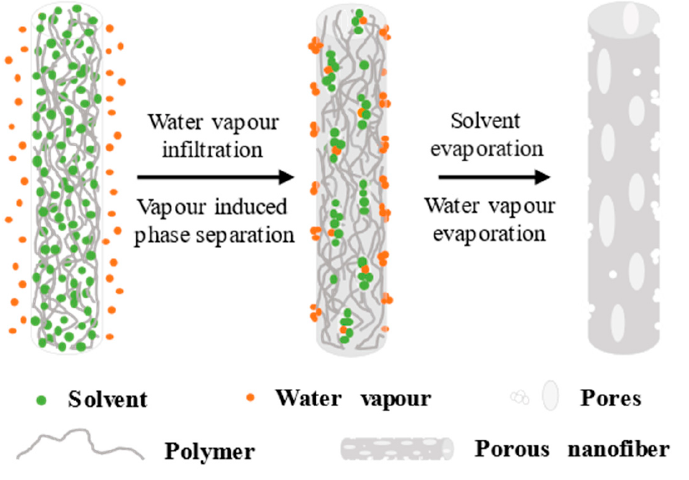
Figure 3. Schematic of the pore − forming mechanism of VIPS.